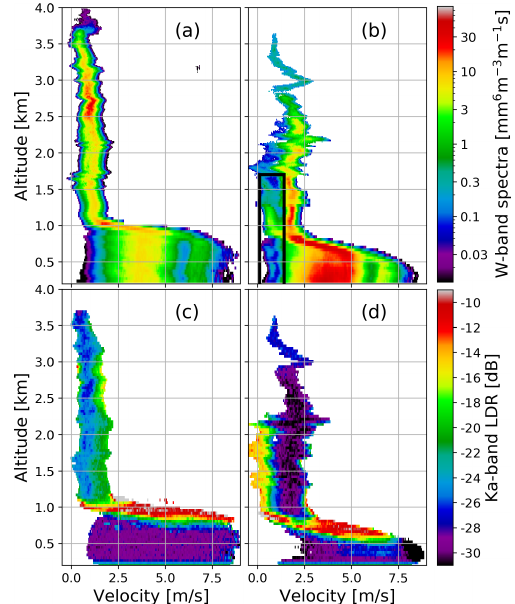
Figure 5. W-band Doppler spectra (a, b) and Ka-band spectral LDR (c, d) . Panels (a) and (c) correspond to the measurements at 07:01UTC dominated by aggregation; panels (b) and (d) were sam- pled at 08:58UTC, when mean Doppler velocities indicate the pres- ence of rimed particles. Only the data where SNR > 3dB are shown. The black box in panel (b) marks the secondary modes in ice and rain. Positive Doppler velocities indicate motions towards the